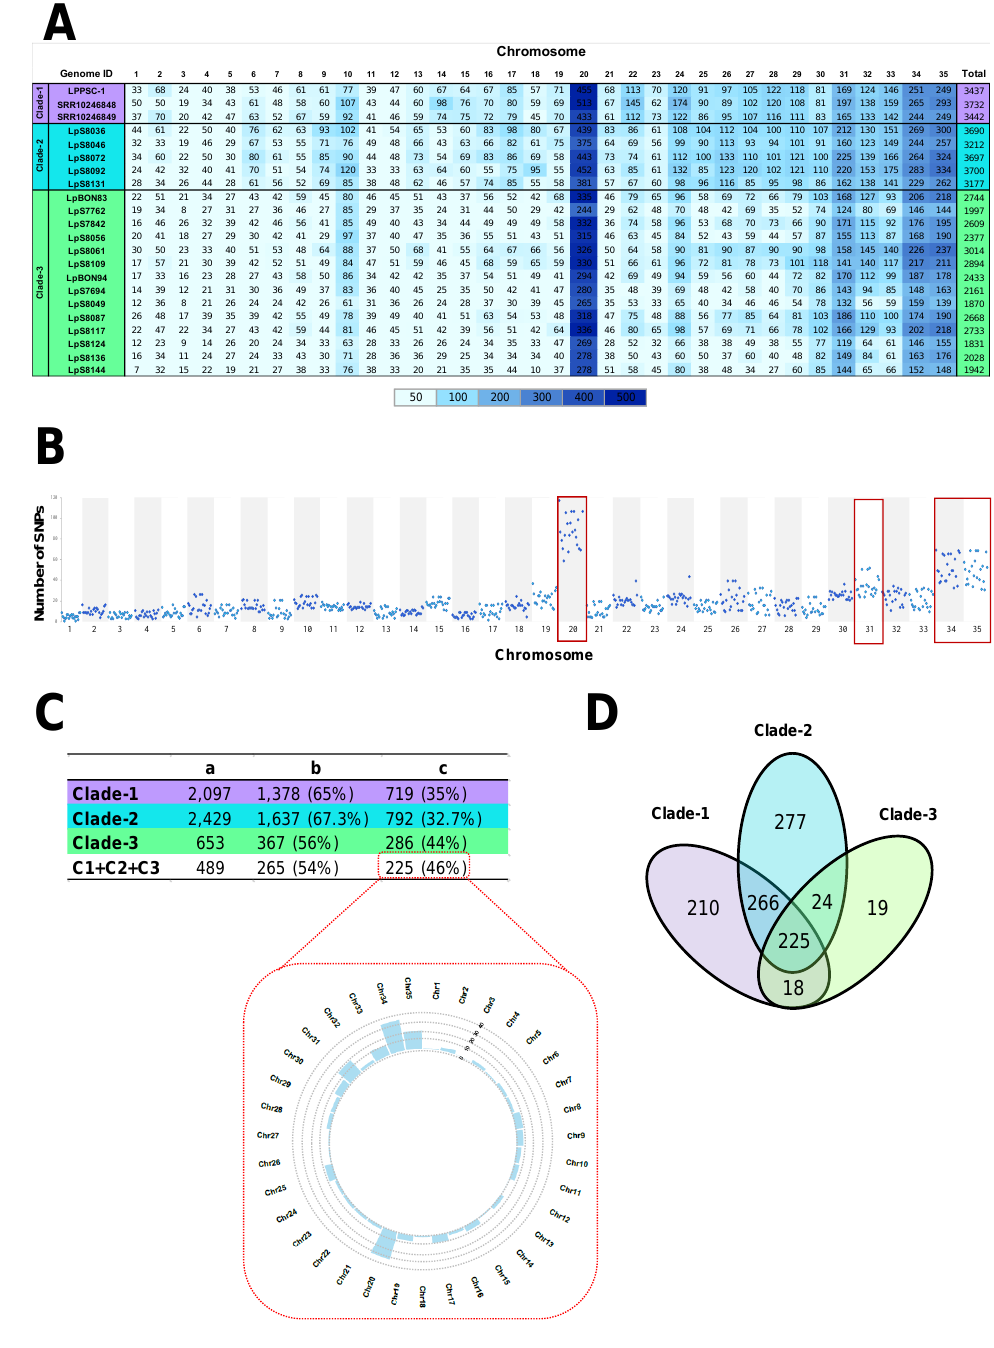
Figure 4. Overview of the SNPs identification results in genomes of L. panamensis. ( A ) Number of SNPs with functional impact per chromosome in each genome analyzed. The total number of SNPs in each genome is presented at the end of the table. ( B ) Density of SNPs per chromosome for every 10 kb of the genomes of L. panamensis herein analyzed. ( C ) Summary of the number of SNPs shared between and within each clade (C1 + C2 + C3 represents the number of SNPs shared between the three clades analyzed). (a) Total number of SNPs shared, (b) number of SNPs shared located in genes encoding hypothetical proteins, (c) number of SNPs shared located in genes encoding annotated proteins. The numbers in the parentheses represent the percent of SNPs. The bottom figure represents the number of SNPs shared per chromosome between three clades. ( D ) Total number of SNPs shared located in genes encoding known proteins, between and within three clades: Purple, sky blue, and green colors represent Clades 1, 2, and 3, respectively.